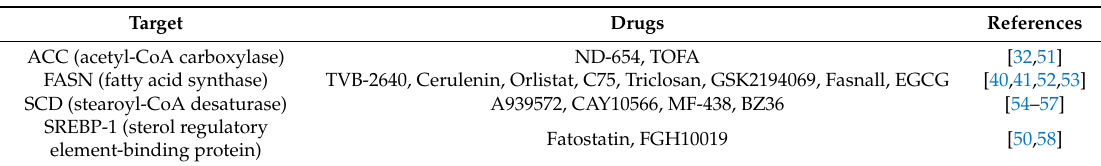
Table 1. Drugs targeting FA biosynthesis pathways for cancer